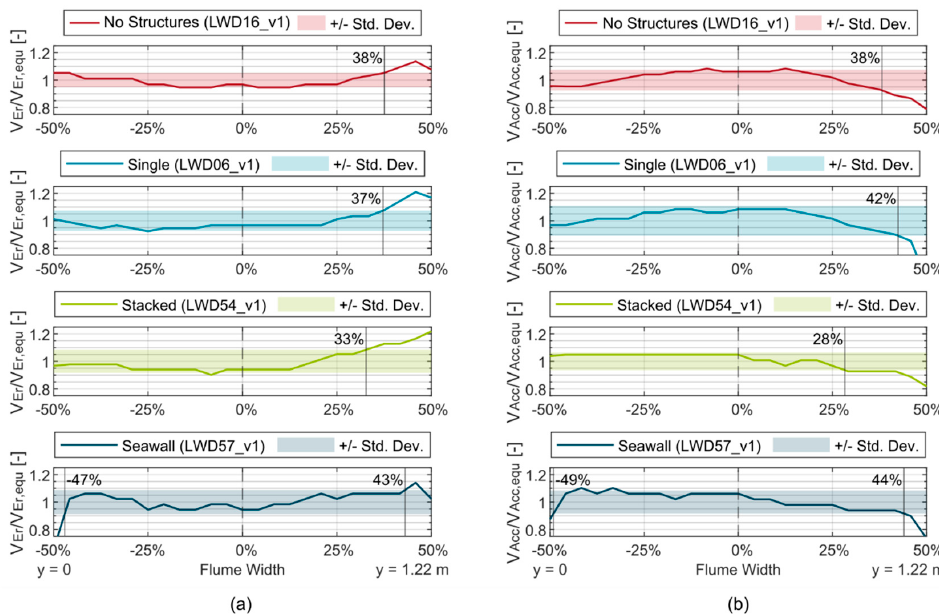
Figure 7. Deviation from a uniform distribution of ( a ) eroded volume (V Er /V Er,equ ), and ( b ) accreted volume (V Acc /V Acc,equ ) over the width of the flume for all tests under medium wave conditions (T p = 2.17 s, H s = 0.15 m).